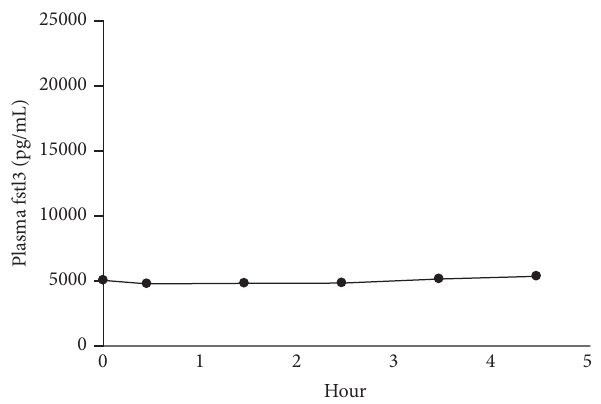
Figure 3: Plasma follistatin-like 3 during a hyperinsulinemic- euglycemic clamp. Plasma fstl3 during a hyperinsulinemic eug- lycemic clamp (0.05 U ∗ min −1 m −2 ). Data is presented as mean ± SEM. Fstl3 was not altered by insulin ( 𝑃 = 0.12 ), one-way ANOVA ( 𝑛 = 6 ).